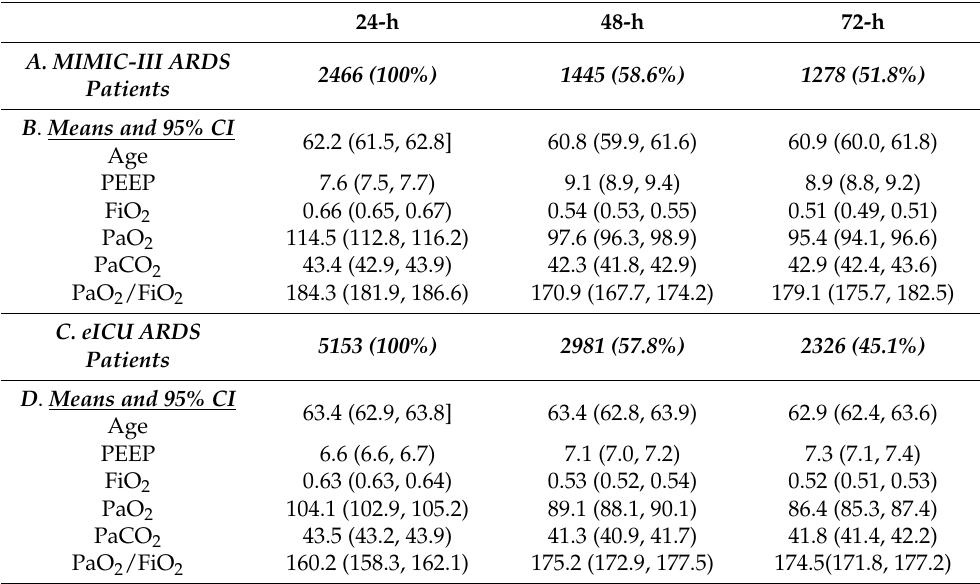
Table 1. Predictors and their descriptive statistics in MIMIC-III and eICU at 24 h, 48 h, and 72 h. 24-h 48-h